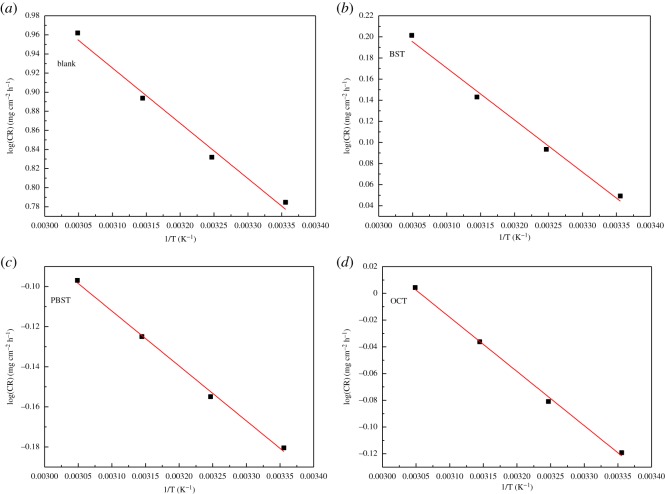
Log CR versus 1/T for Q235 mild steel in 0.5 M H2SO4 solution.